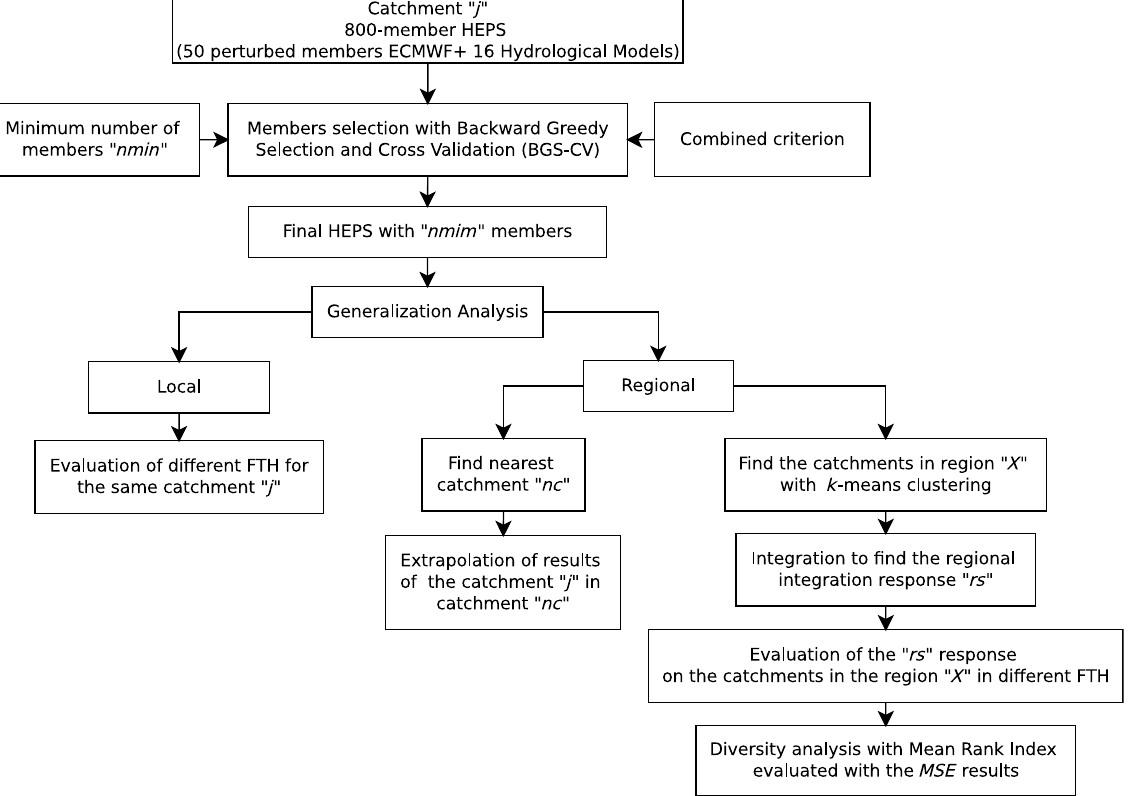
Fig. 2. Generalization test methodology for the hydrological members’ selection found with BGS-CV.